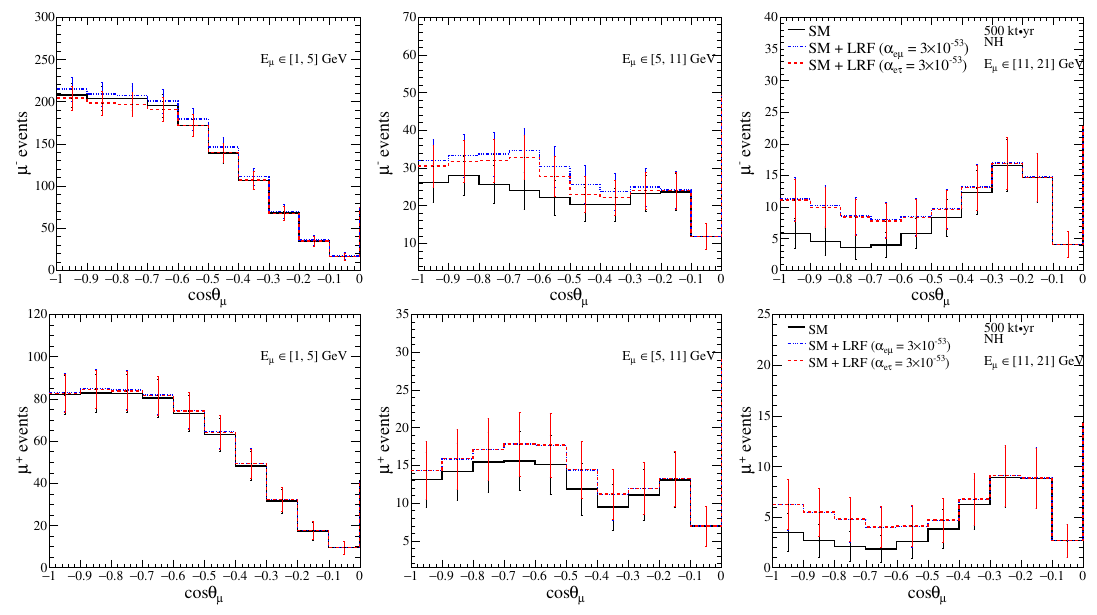
Figure 9 . The distributions of (cid:22) (cid:0) (upper panels) and (cid:22) + (lower panels) events for three di(cid:11)erent E (cid:22) bins: 1 to 5 GeV in left panel, 5 to 11 GeV in middle panel, and 11 to 21 GeV in right panel. In each panel, we consider three di(cid:11)erent cases: i) (cid:11) e(cid:22) = (cid:11) e(cid:28) = 0 (the SM case, black solid line), ii) (cid:11) e(cid:22) = 3 (cid:2) 10 (cid:0) 53 , (cid:11) e(cid:28) = 0 (blue dash-dotted line), and iii) (cid:11) e(cid:22) = 0, (cid:11) e(cid:28) = 3 (cid:2) 10 (cid:0) 53 (red dashed line). Here, we sum over E 0 in its entire range of 0 to 25 GeV and show the results for 500 kt (cid:1) yr had exposure and assuming